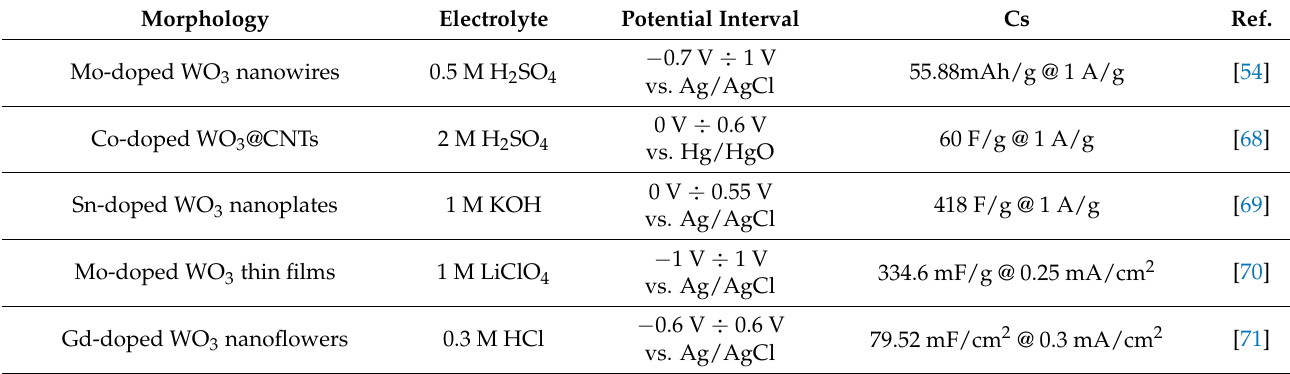
Table 3. State-of-the-art on energy storage applications of metal doped WO 3 -based electrodes. Morphology Electrolyte Potential Interval Cs